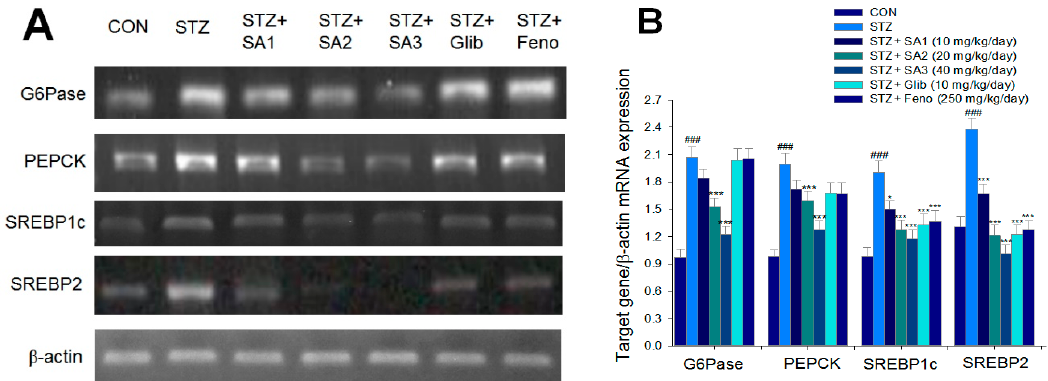
Figure 5. Semiquantative reverse transcription-polymerase chain reaction (RT-PCR) analysis on targeted gene mRNA levels in liver tissue of the mice by oral gavage sulphurenic acid (SA) (SA1, SA2, and SA3, 10, 20 and 40 mg/kg body weight), glibenclamide (Glib; 10 mg/kg body weight), or fenofibrate (Feno; 250 mg/kg body weight). ( A ) Representative image; ( B ) quantification of the ratio of target gene to β -actin mRNA expression. Total RNA (1 μ g) isolated from tissue was reverse transcripted by MMLV-RT; 10 µ L of RT products were used as templates for PCR. The expression levels of G6Pase, PEPCK, SREBP1c, and SREBP2 mRNA were measured and quantified by image analysis. Values were normalized to β -actin mRNA expression. All values are means ± SE ( n = 7 per group). ### p < 0.001 compared with the control (CON) group; *** p < 0.001, * p < 0.05 compared with the streptozotocin plus vehicle (distilled water) (STZ) group.